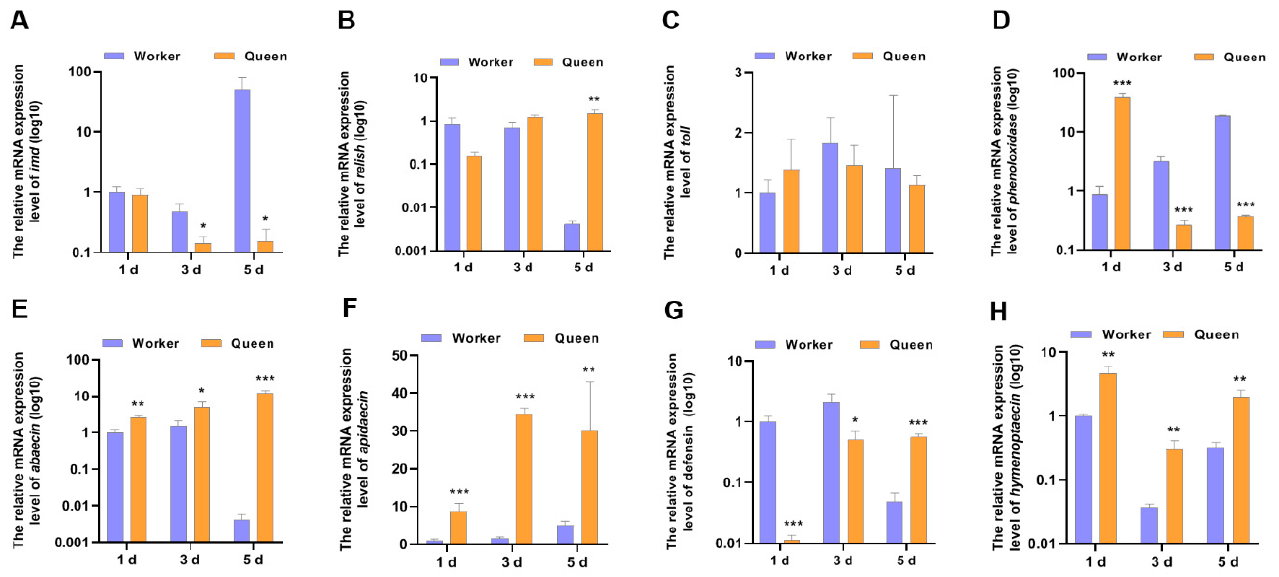
Figure 2. The mRNA expression levels of the genes involved in immune. * represents p < 0.05, ** ** represents p < 0.01, *** represents p < 0.001, N queen = 9, N worker = represents p < 0.01, *** represents p < 0.001, N queen = 9, N worker = 12.